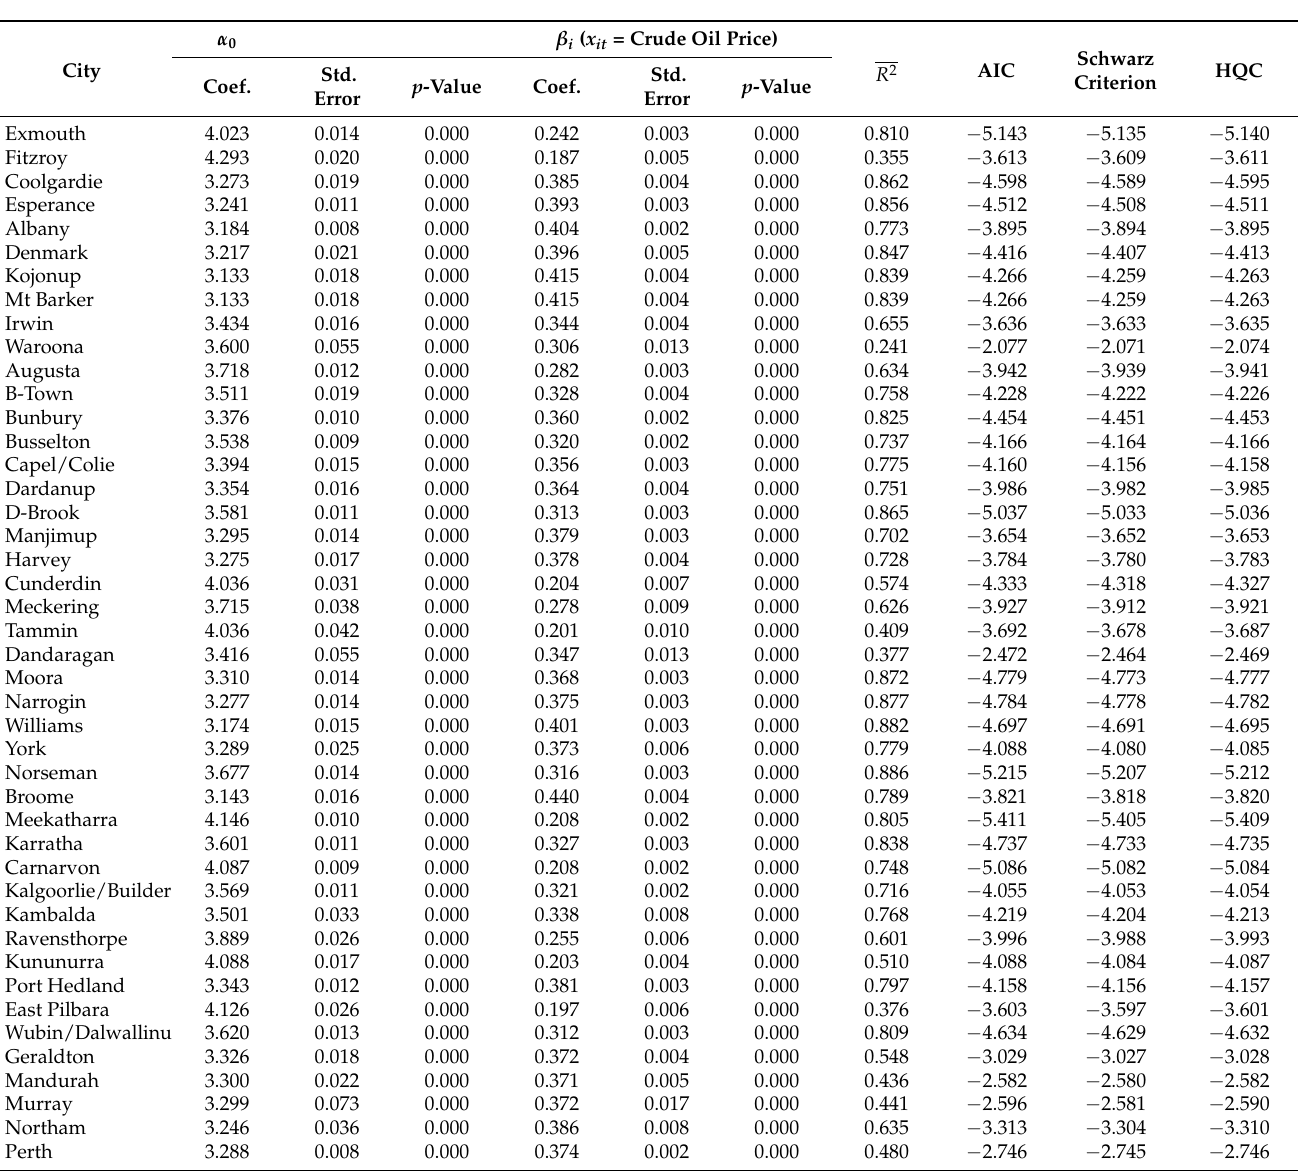
Table 7. The relationship between the retail petrol price and crude oil price, Model A: logp it = α + β i logx it + ε it